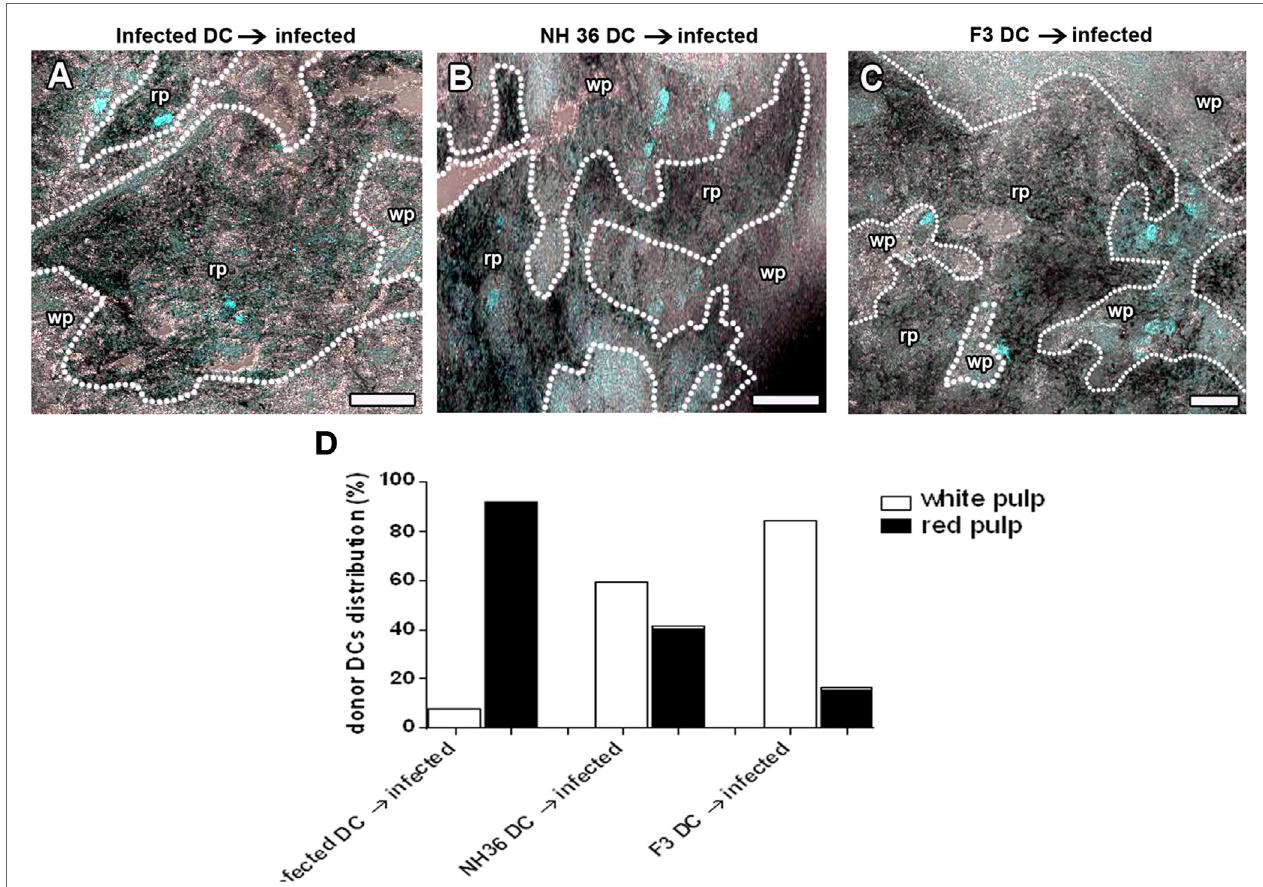
FigUre 4 | F3-primed dendritic cells (DCs) migrate to the spleen white pulp (wp) of infected mice. DCs of day 28-infected mice and F3- and NH36-primed and -challenged mice were labeled with Hoescht nuclear fluorescent stain, and injected into 28-day-infected mice. Recipient mice were euthanized 24 h after injection. Spleens were fixed and frozen and the distribution of stained DCs was assessed in cryostat sections to confirm the in vivo migration of DCs. We show the image overlay of cryostat sections from bright field to evidence spleen morphology, and confocal image to show Hoescht labeled cells in blue. The dotted lines indicate the marginal zone (MZ) which separates the red pulp (rp) from the wp. It is possible to observe the localization of the labeled DCs in mice that received DCs from infected (a) , NH 36- (B) , or F3-vaccinated donors (c) as well as the distribution of these cells (D) . Scale bar = 120 µm. Data are representative of one experiment with three mice per treatment. DCs from infected donors remain mostly in the rp (92%; p < 0.001). DCs from NH36-vaccinated mice are equally distributed between the white and the rp ( p = 0.1144) while 84% ( p < 0.0001) of DCs from F3-vaccinated mice migrated to the wp and its MZ (c)